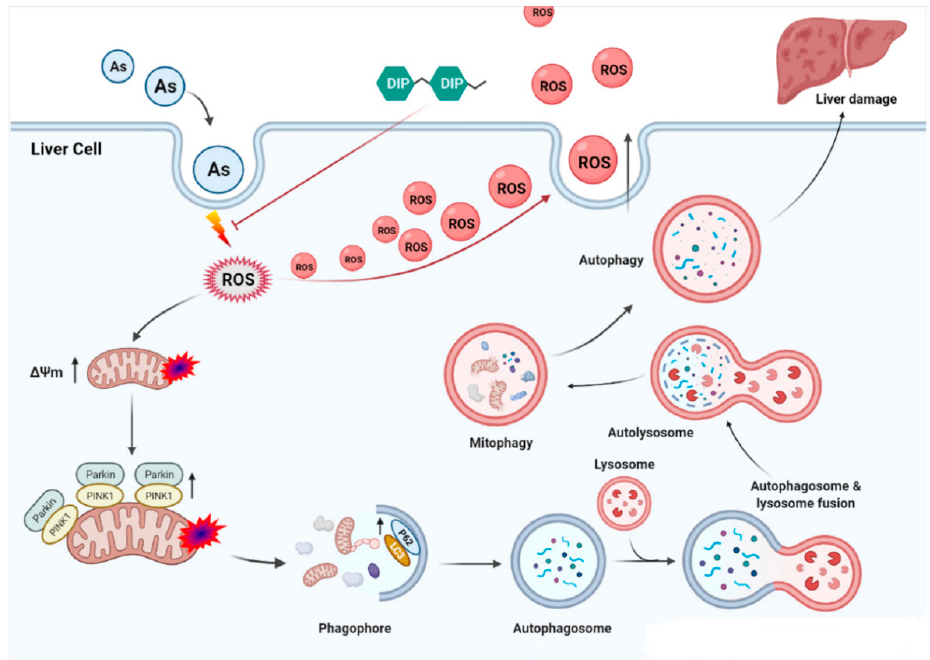
Figure 5. DIP attenuates PINK1/Parkin pathway-mediated mitophagy damage in L-02 cell through scavenging ROS. Mitophagy was found in hepatocytes induced by arsenic exposure, and DIP exerts a protective effect on hepatocyte by scavenging ROS, which could restrain arsenic-induced mitochondrial membrane potential depolarization and PINK1/Parkin pathway-mediated mitophagy to inhibit hepatocyte injury.